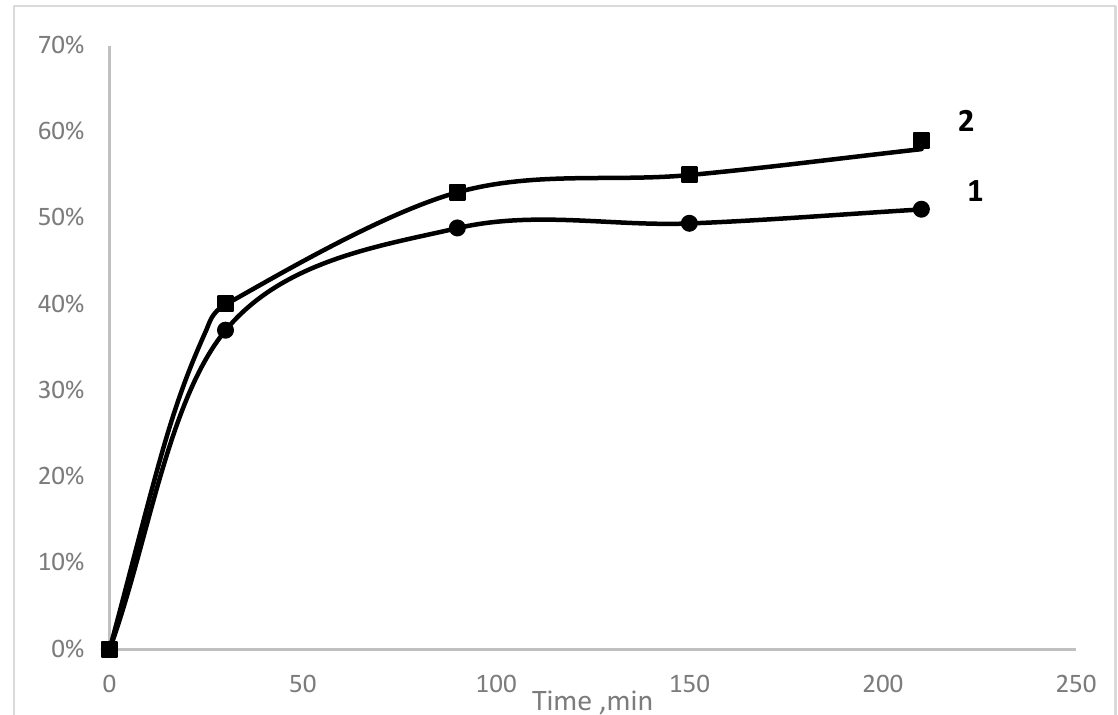
Figure 12. Condensation of acetophenone and aniline over Au@meso-UiO-66 nanocatalyst into imine. Acetophenone:aniline molar ratio is 1:2. 1 . Yield; 2 . Conversion.